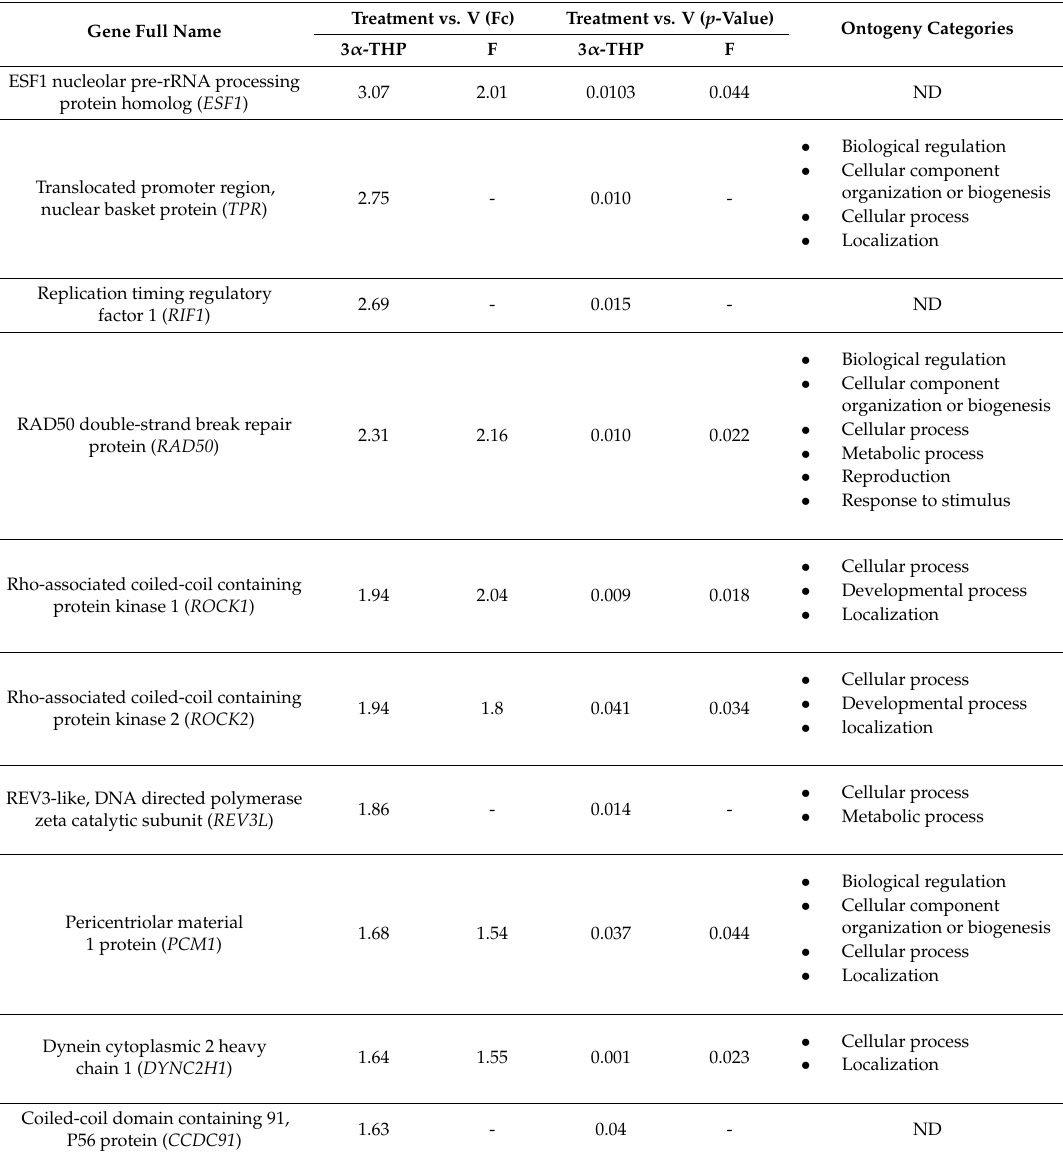
Table 1. The microarray data (Fc and p -value) and the ontogeny analysis of the selected genes for